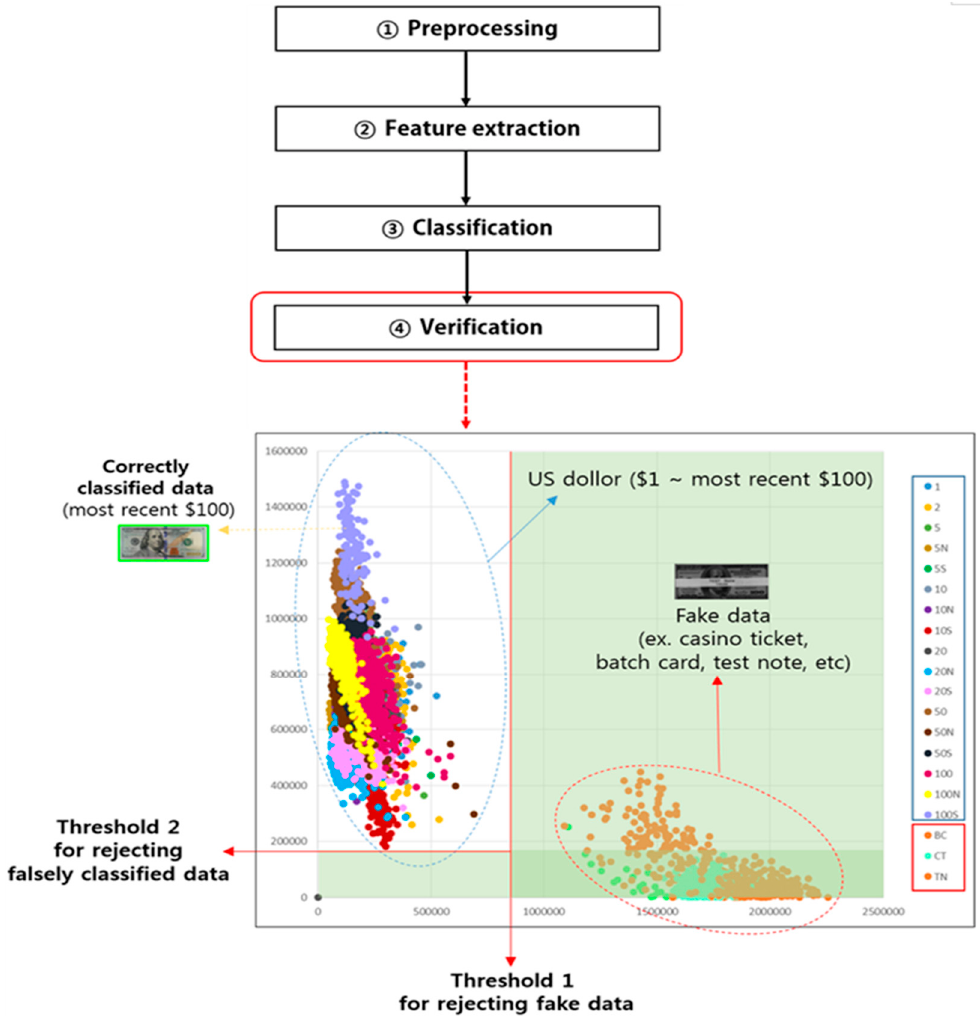
Figure 9. Verification example in the banknote recognition process flow.